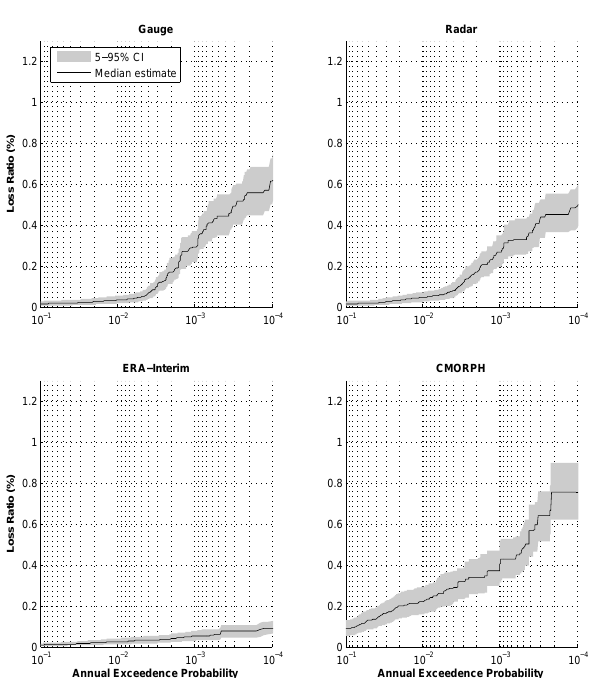
Figure 9. Exceedance probability plots produced by the model when trained using the four different precipitation data sets. The grey shaded area denotes the 5–95% confidence intervals generated by uncertainty within the vulnerability